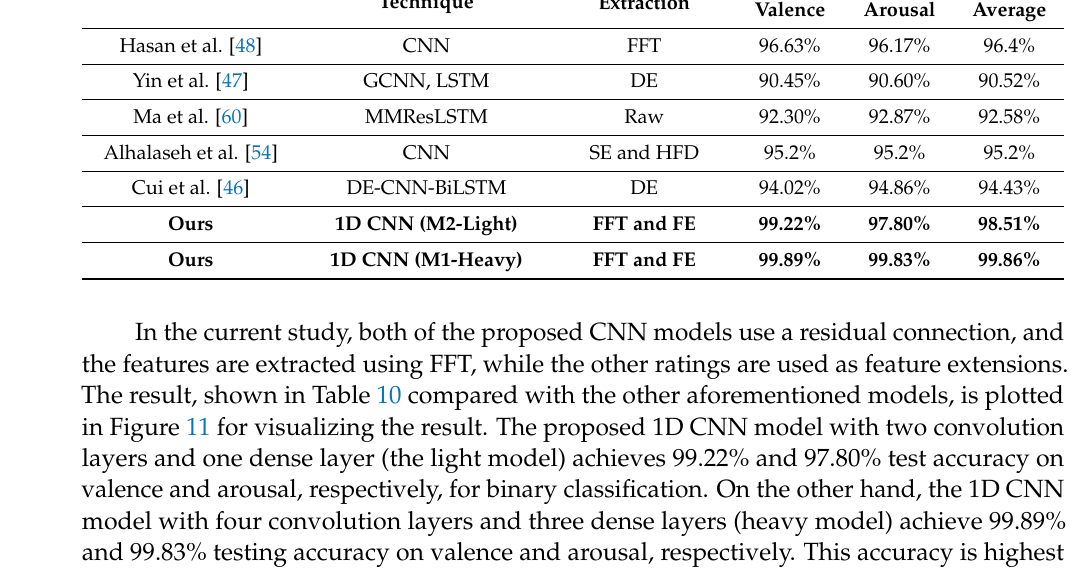
Table 10. Comparison of our results with state-of-the-art results on binary classification on DEAP. Modeling Research Technique